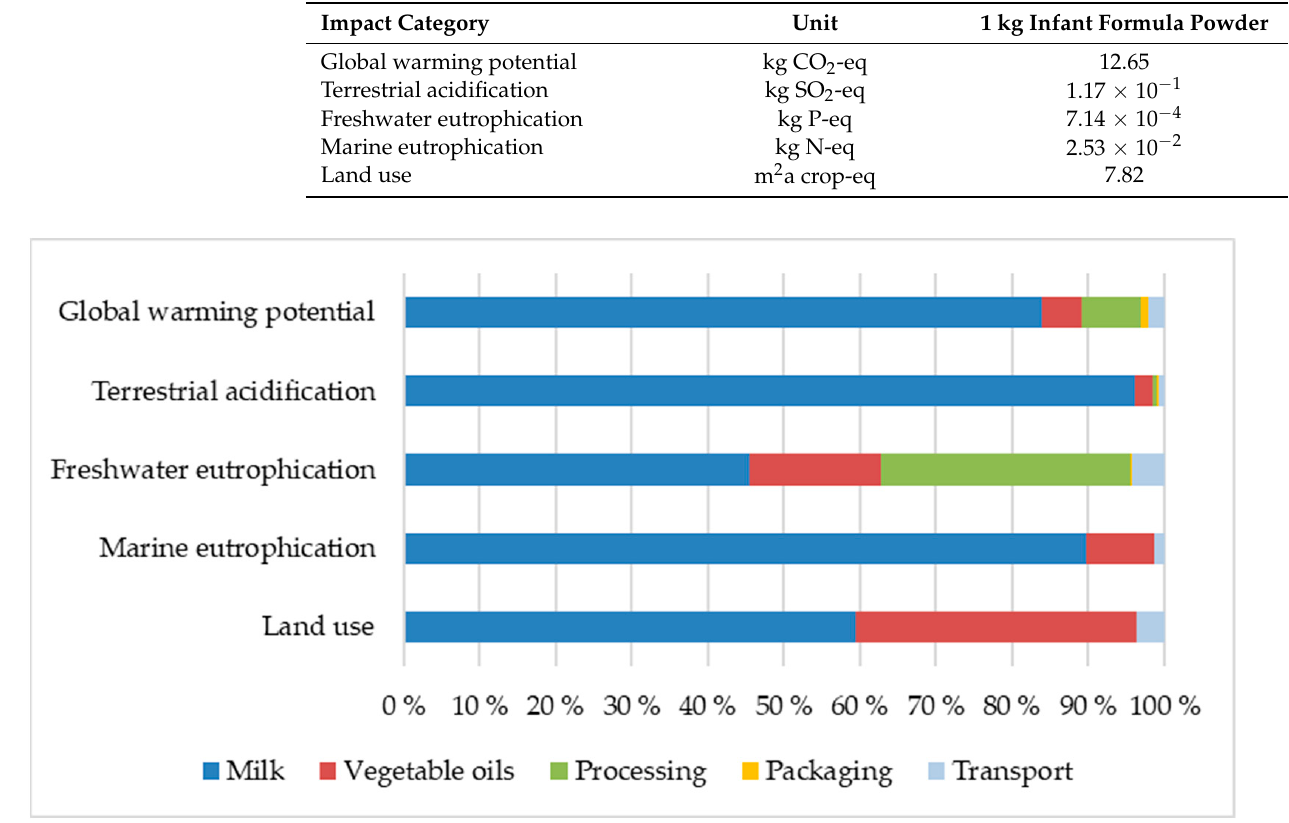
Table 2. Environmental impact from production and distribution of 1 kg infant formula powder.